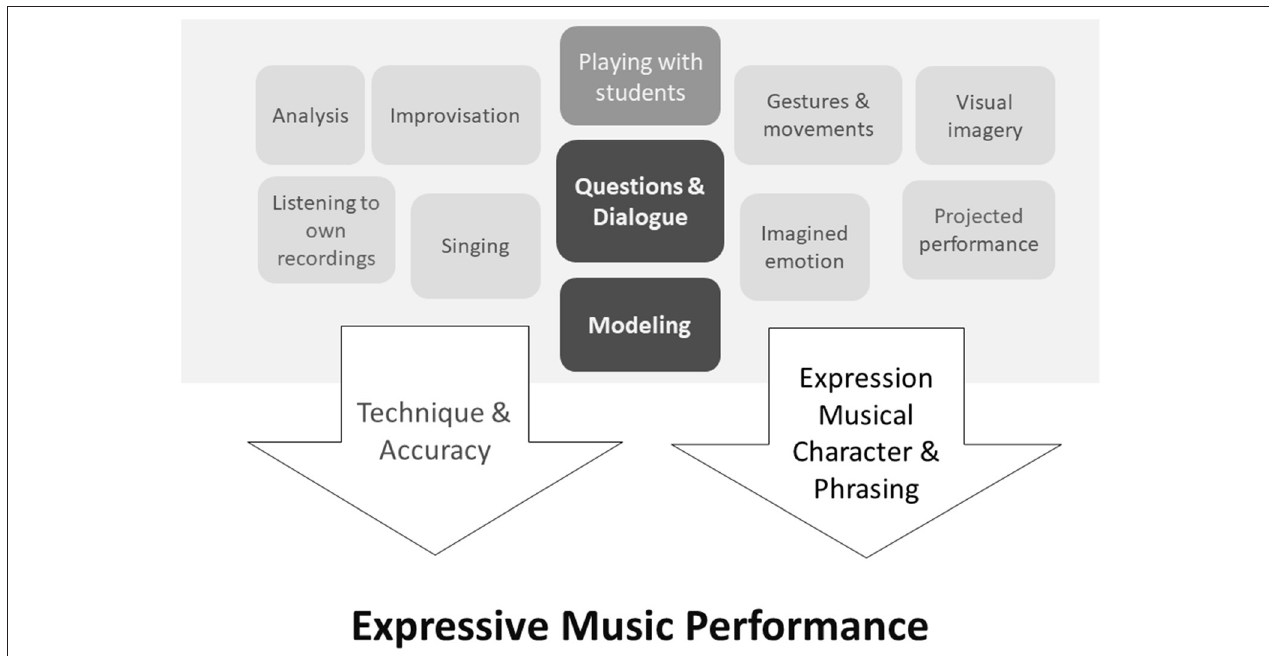
FIGURE 4 | Depiction of ARP-tutors’ views on using questions and dialogue combined with other instructional strategies to support the teaching and learning of expressive music performance.